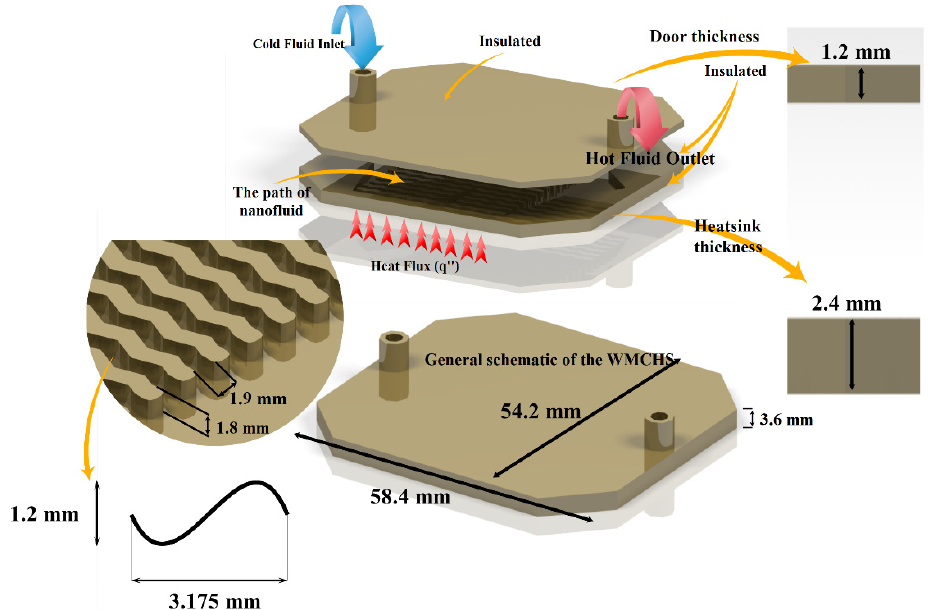
Figure 1. The model and boundary conditions applying to the geometry of the problem.